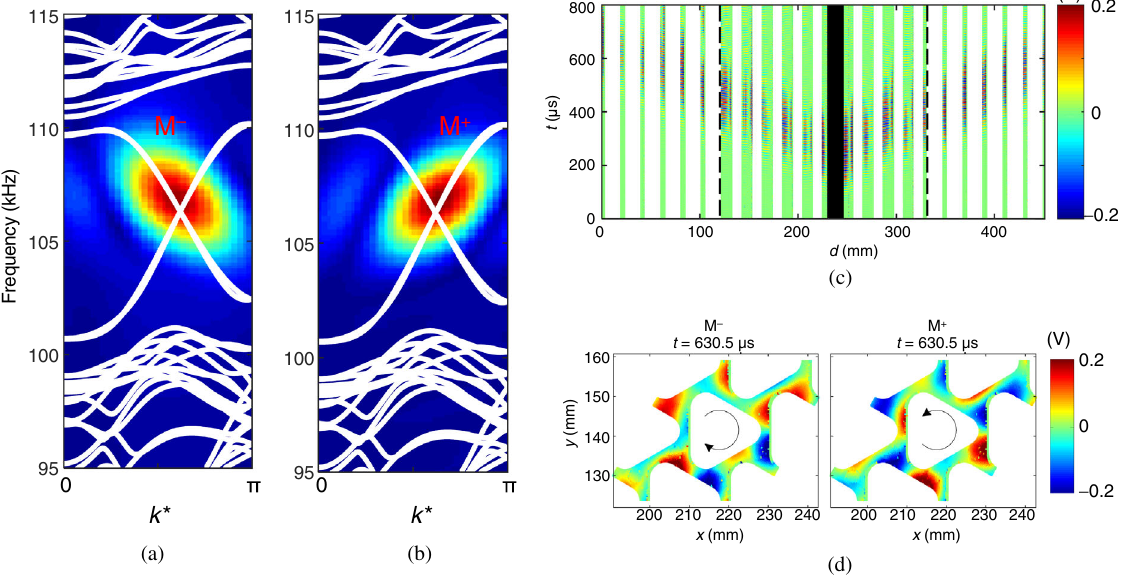
FIG. 4. Observation of the topologically protected helical edge modes. (a,b) Measured dispersion curves for the left- and right- propagating edge modes (denoted as M − and M þ , respectively), compared to the numerically predicted band structure (white lines). (c) Spatio-temporal representation of the plate response recorded during the 1D SLDV scan along the Z -shaped interface. The total length of the scanned line is 430 mm and includes the bottom-straight, oblique, and top-straight segments [orange circular dots in Fig. 1(d)]. The black rectangle positioned at d ¼ 230 mm, where d denotes the curvilinear coordinate along the interface, denotes the position of the piezoelectric transducer used for excitation. White rectangles correspond to holes in the patterned plate where SLDV measurements were not taken. The two dashed black vertical lines mark the location of the turns along the interface. (d) Measured wave field for the left- and right-propagating edge modes M − and M þ displaying typical vortex profiles. The black arrows denote anticlockwise and clockwise vorticity of the displacement field. The measurement corresponds to the area denoted as “ 2D fine scan ” in Fig. 1(d). The SLDV sensitivity is set to 20 mm = s = V for all the measurements